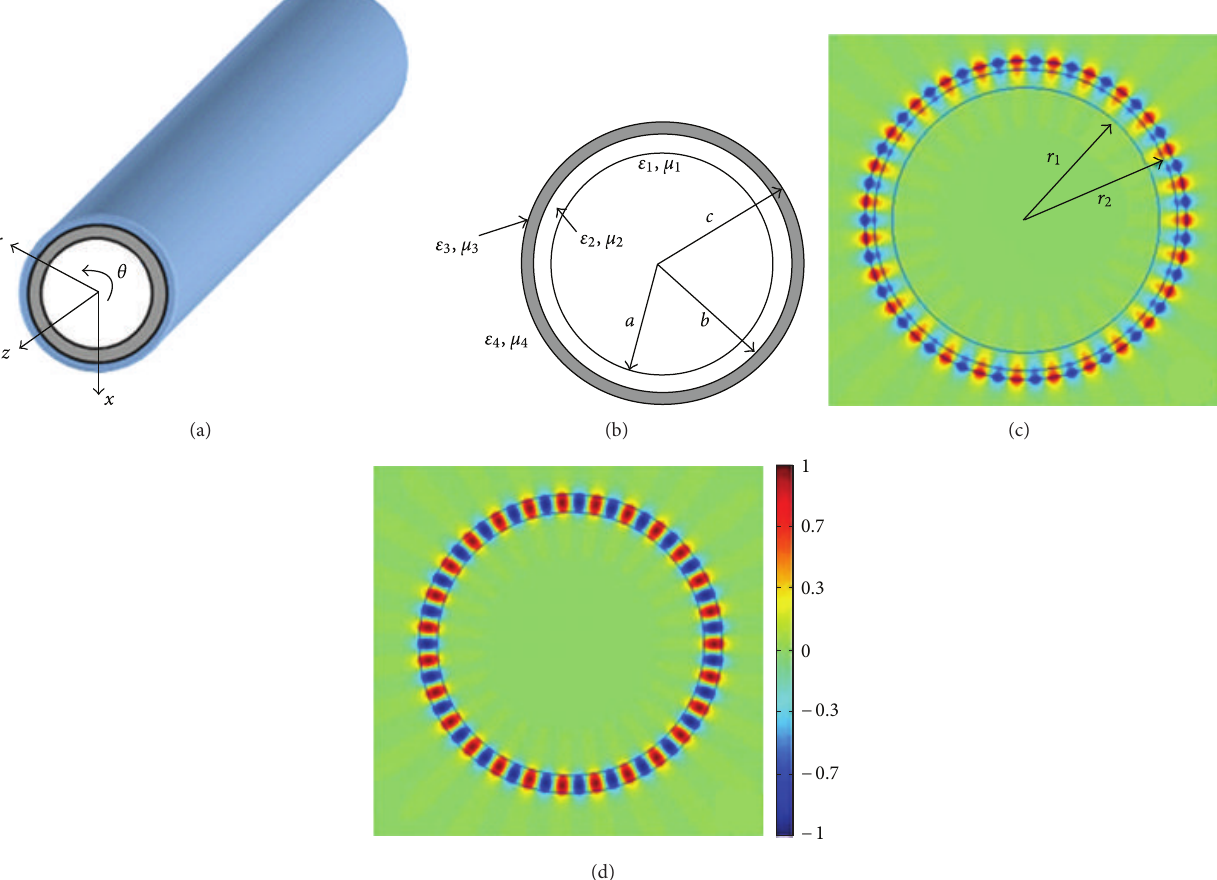
Figure 5: (a) Cylindrical dielectric waveguide covered with a layer of metamaterials. (b) Cross-section of (a). Analytical results of normalized electric field distribution (mode 27) in the cross-section of the waveguide with (c) and without the metamaterial layer (d) [21].